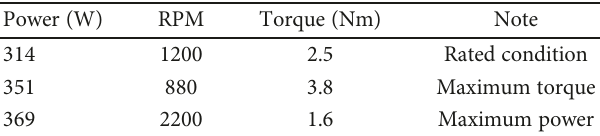
Table 2: Speci fi cation of DC